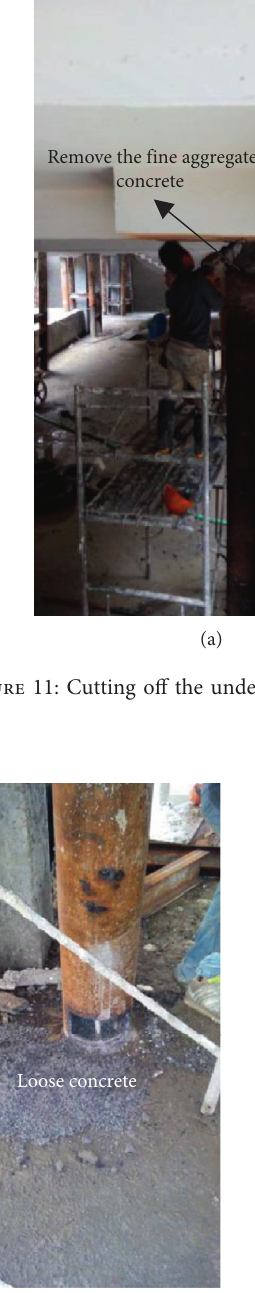
Figure 12: Loose concrete at the pile lower part.